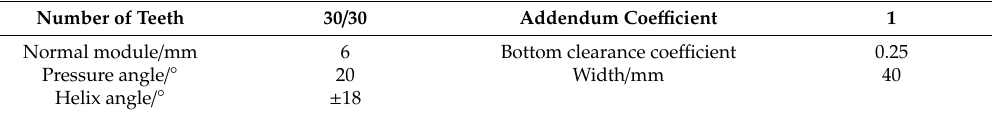
Table 1. Parameters of helical gear pair.